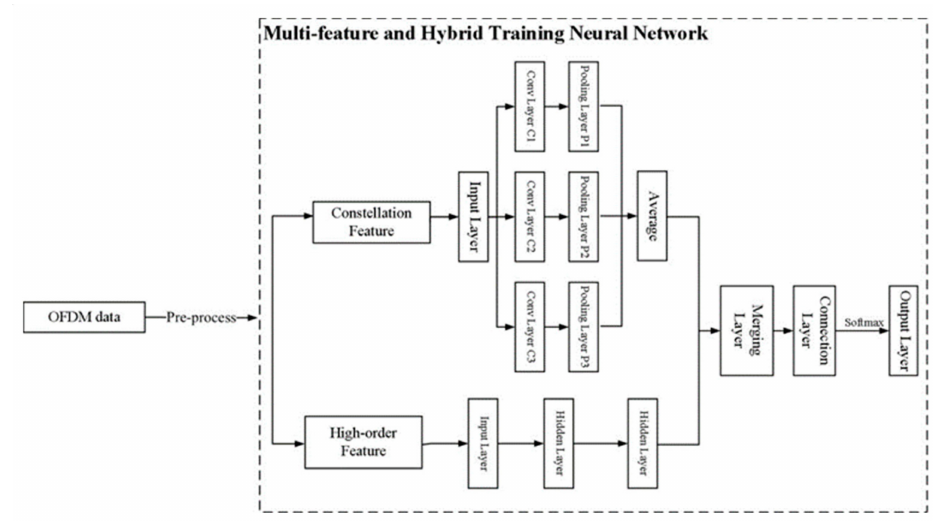
Figure 3. Structure diagram of Hybrid Training Neural Network (HTNN) based on multi-feature input.